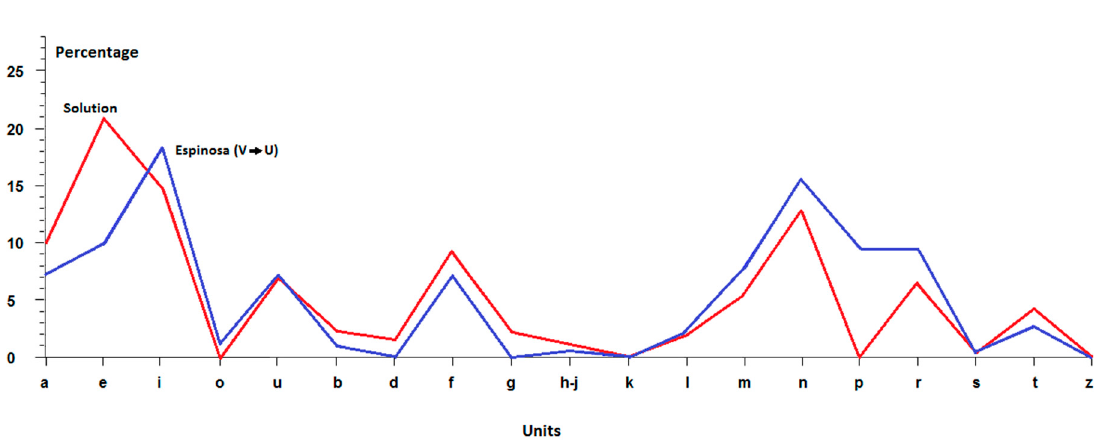
Figure 2. Frequency values of the (19) reduced phonetic units of the original lexical proposal for solution, in contrast to Espinosa’s version, in which V is replaced with